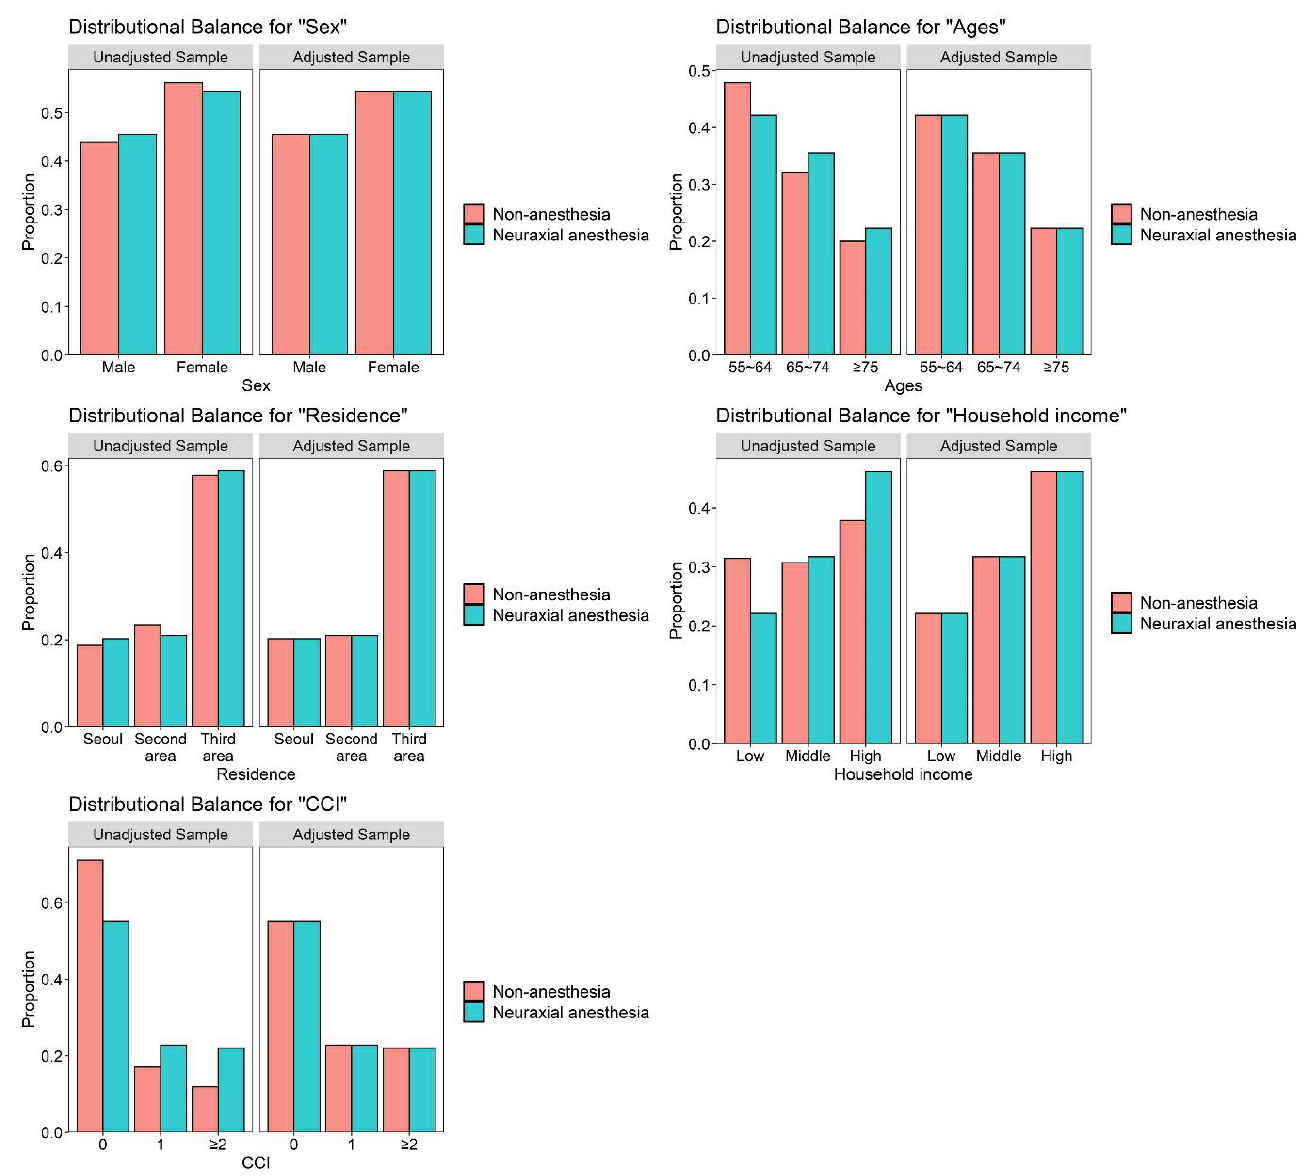
Figure 2. Balance plot for five variables before and after matching. Table 2. Incidence per 1000 person-years and HR (95% CIs) of dementia during the follow-up period. Variables N Case